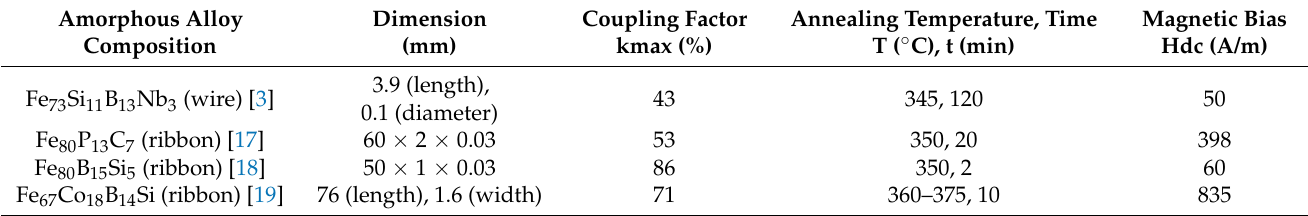
Table 1. The magnetomechancial coupling factors of typical Fe-based amorphous alloys. Amorphous Alloy Dimension Coupling Factor Annealing Temperature, Time Magnetic Bias Composition (mm) kmax (%) T ( ◦ C), t (min) Hdc (A/m) 3.9 (length), Fe 73 Si 11 B 13 Nb 3 (wire) [3] Fe 80 P 13 C 7 (ribbon) [17] 60 × 2 × 0.03 53 350, 20 398 Fe 80 B 15 Si 5 (ribbon) [18] 50 × 1 × 0.03 360–375,